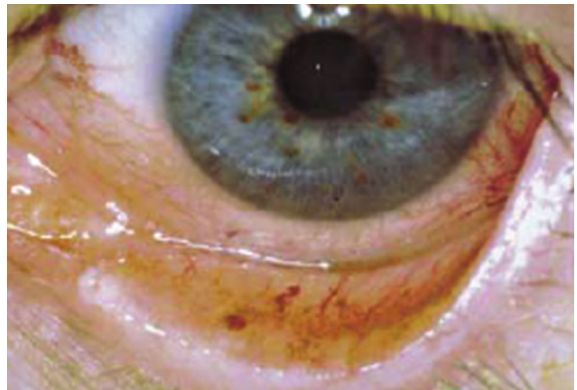
Figure 9: Telangiectasias on the inner side of the lower eyelid in a HHT